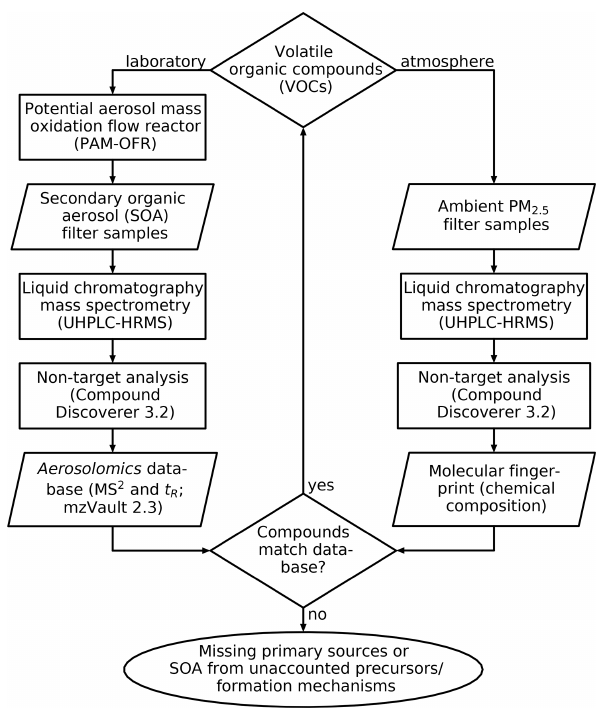
Figure 1. Establishment and application of the Aerosolomics database. The database is filled with the results of several PAM- OFR experiments with different precursors and reactants and is compared to the molecular fingerprints of ambient PM 2 . 5 filter sam- ples. Matching compounds can be assigned to the corresponding VOC precursor. Knowledge about non-matching compounds, due to missing primary sources or SOA from unaccounted precursors or formation mechanisms, can guide further